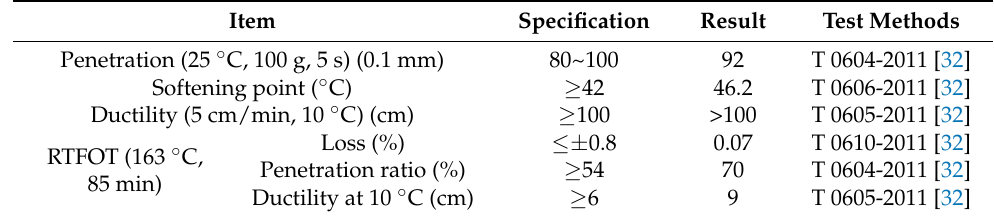
Table 1. Technical properties of neat petroleum asphalt.